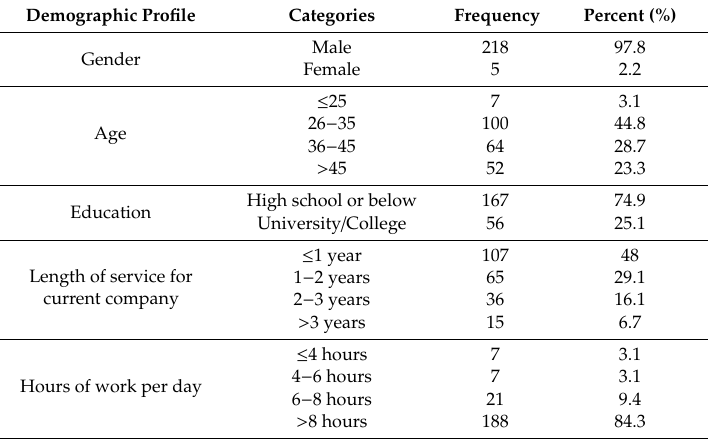
Table 2. Demographic characteristics of the survey participants ( n =